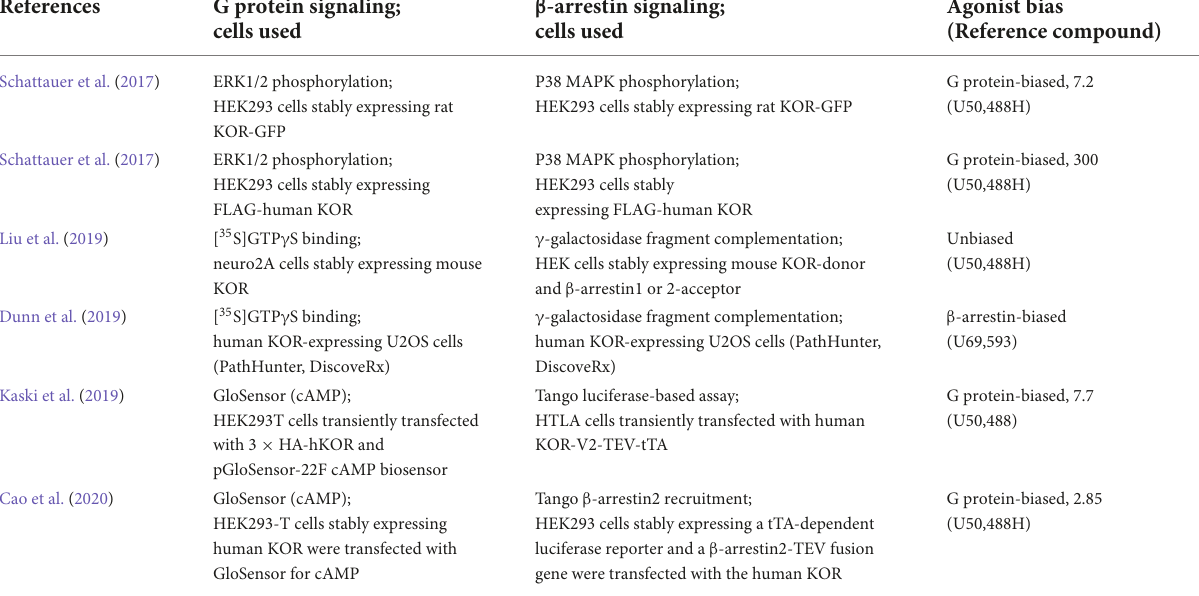
TABLE 2 Determination of in vitro agonist biases of nalfurafine [Reproduced from (Zhou et al.,